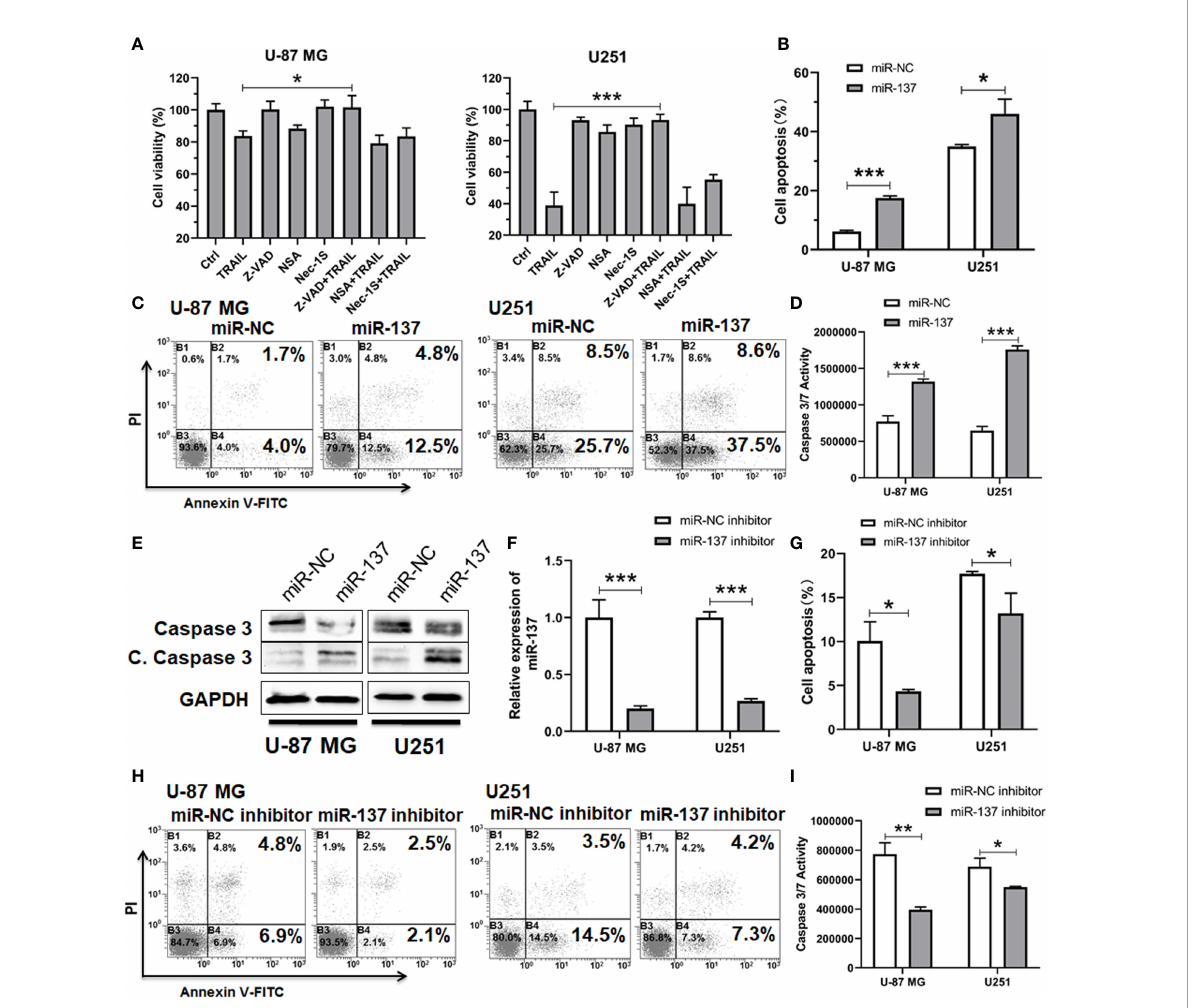
FIGURE 2 miR-137 increased the sensitivity of U-87 MG/U251 cells to TRAIL-induced apoptosis. (A) Cell viability of U-87 MG/U251 cells initially transfected with miR-137 followed by 24 h treatment with TRAIL and/or different inhibitor determined by CCK-8 assay. Z-VAD, pan-caspase inhibitor; NSA (Necrosulfonamide), MLKL inhibitor; Nec-1s (Necrostatin 2 racemate), RIPK1 inhibitor. (B) Cell apoptosis of U-87 MG/U251 cells initially transfected with miR-NC or miR-137 24 h followed by 48 h TRAIL treatment determined by FCM analysis with Annexin-V and